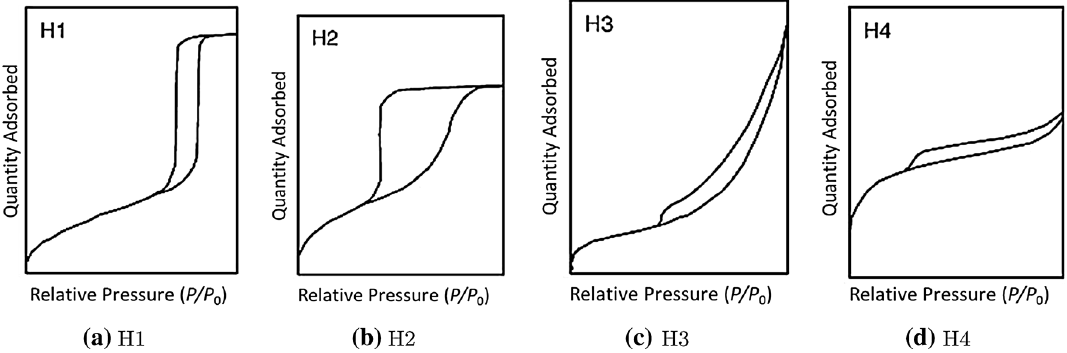
Fig. 3 The four hysteresis shapes of adsorption isotherm usually found by subcritical N